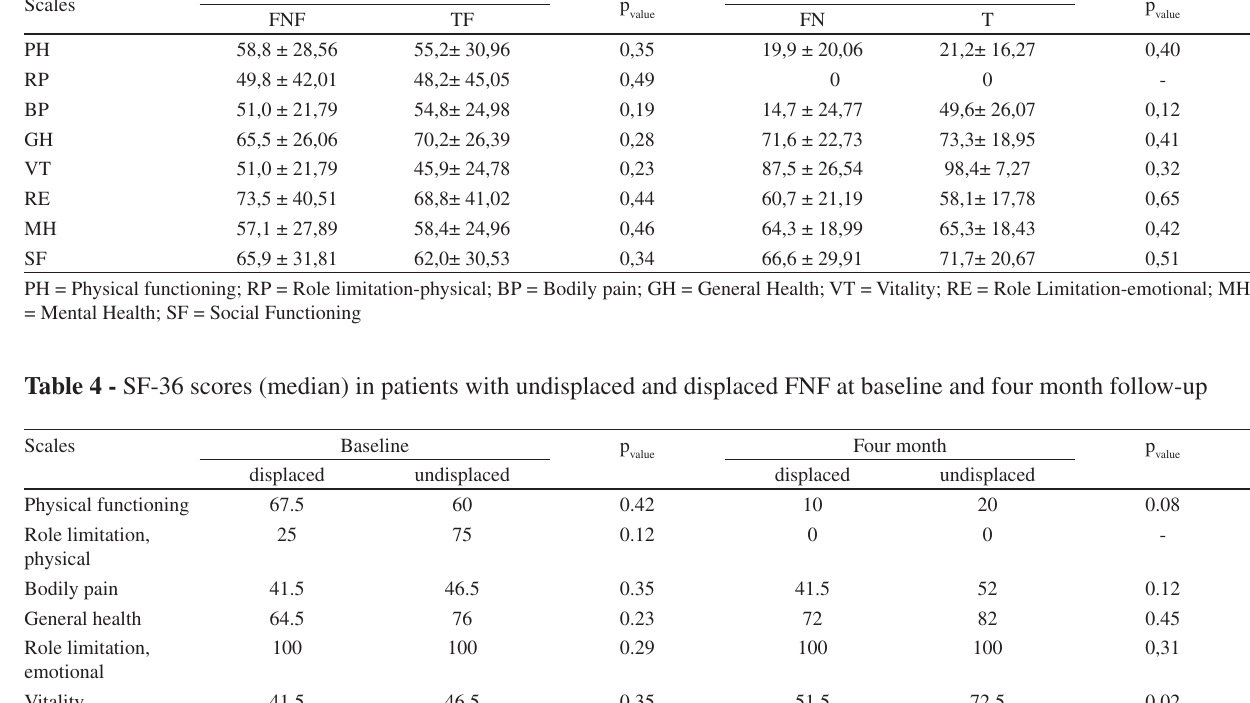
Table 3 - SF-36 scores (mean, SD) in patients with hip fractures at baseline and four month follow-up Scales